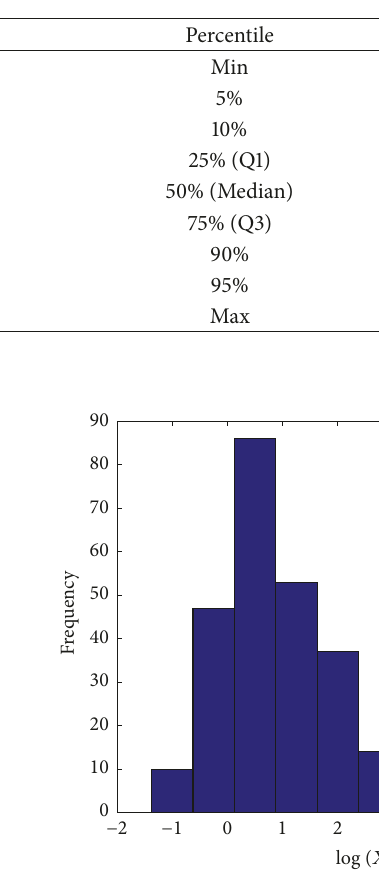
Table 1: Summary statistics for PCS loss index.